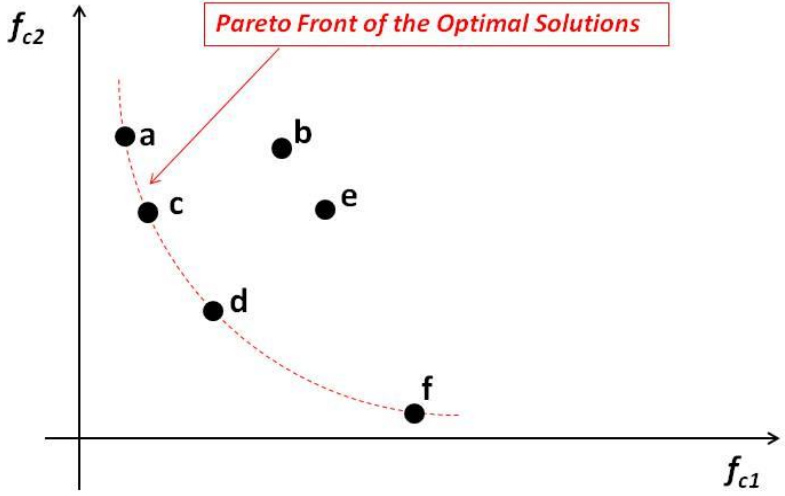
Figure 4. Solutions on the cost function plane. The optimal Pareto front is the dashed line formed by the optimal non-dominated solutions.